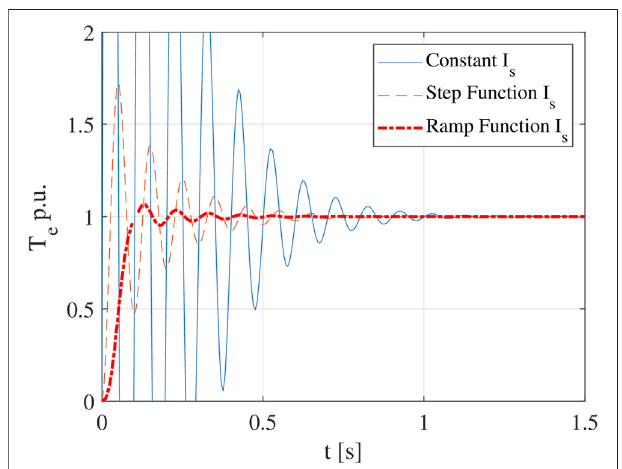
FIGURE 2 | Torque waveform of the three methods (analytical